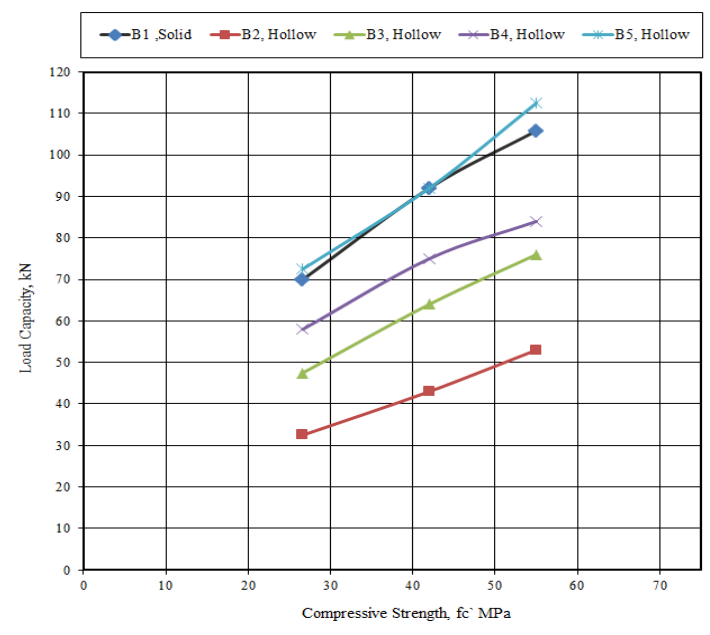
Figure 23. Load carrying capacity versus concrete compressive strength relationships.